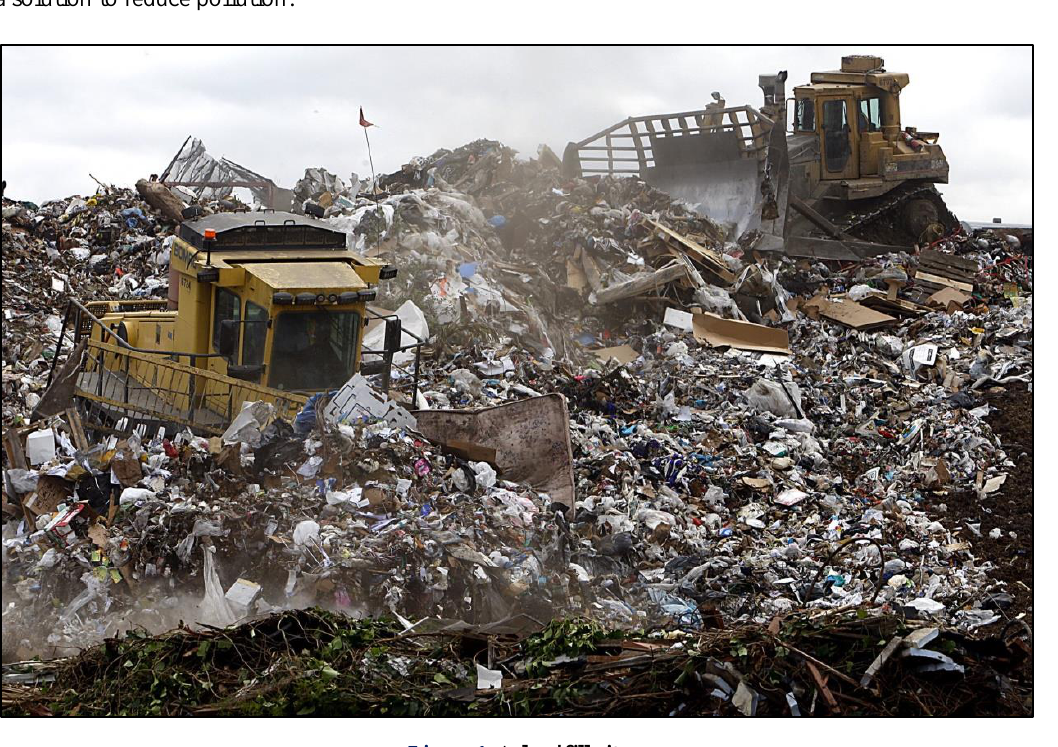
Figure 1. A landfill